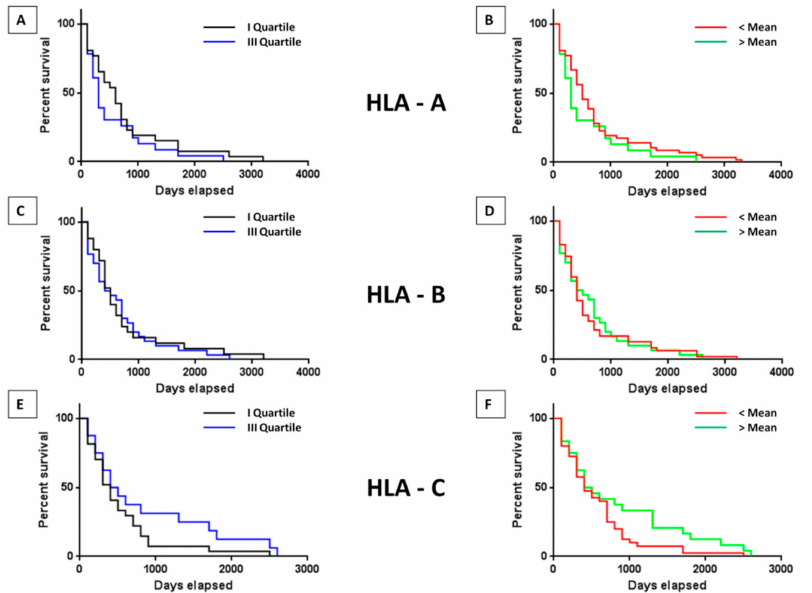
Figure 5. HLA-associated neoantigens and survival. Survival of HCC patients with high and low number or quality of predicted neoantigens associated with the three main HLA alleles in the validation set, considering the value in the I and the III quartiles ( A , C , E ) as well as the value below and above the mean ( B , D , F